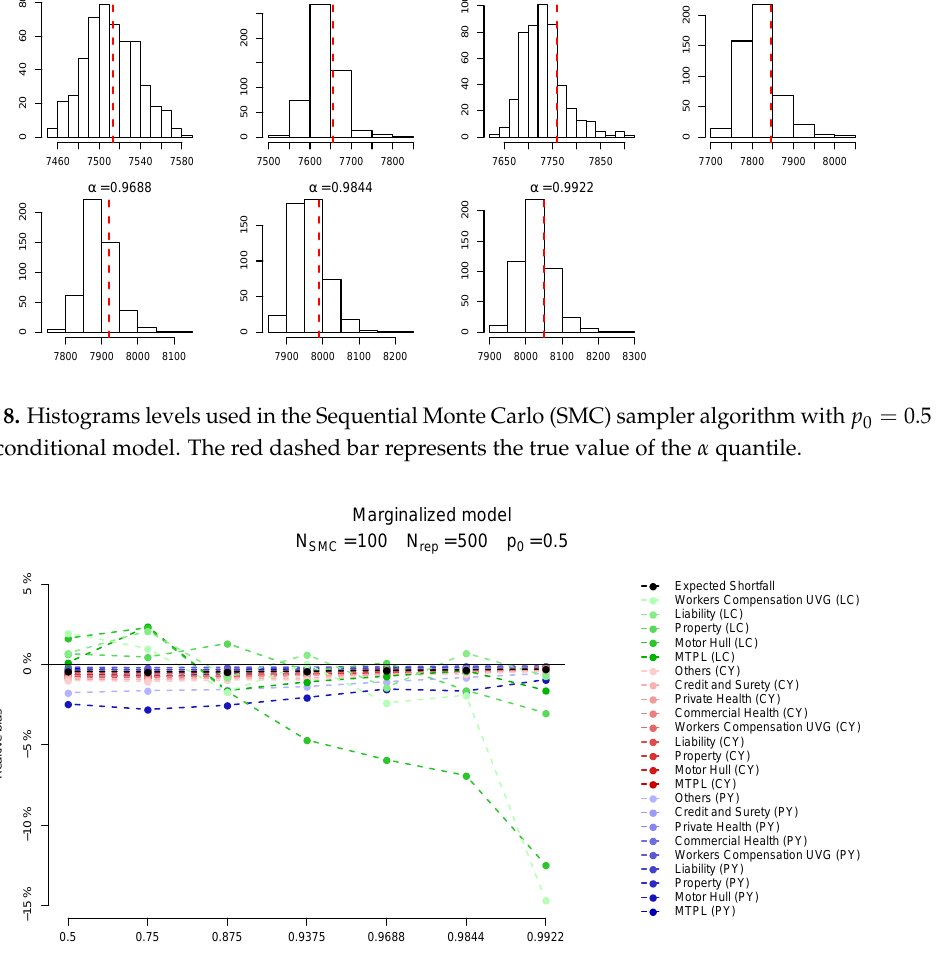
Figure 9. Bias for the marginalized model. Note that although the bias for some of the CY large claims is around 10% their allocated capital is rather small, as seen in Figure 11